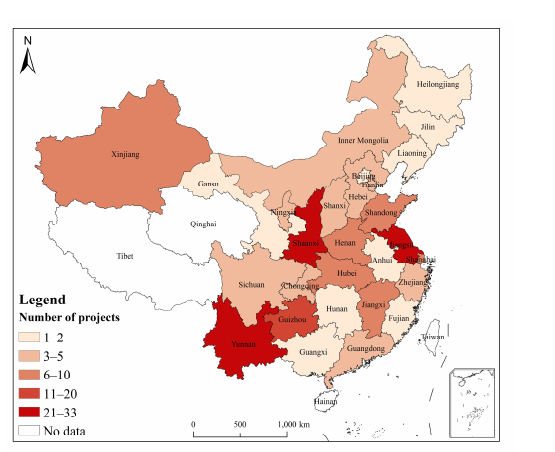
Figure 2. Timeline of Provinces to implement WSMC programs.